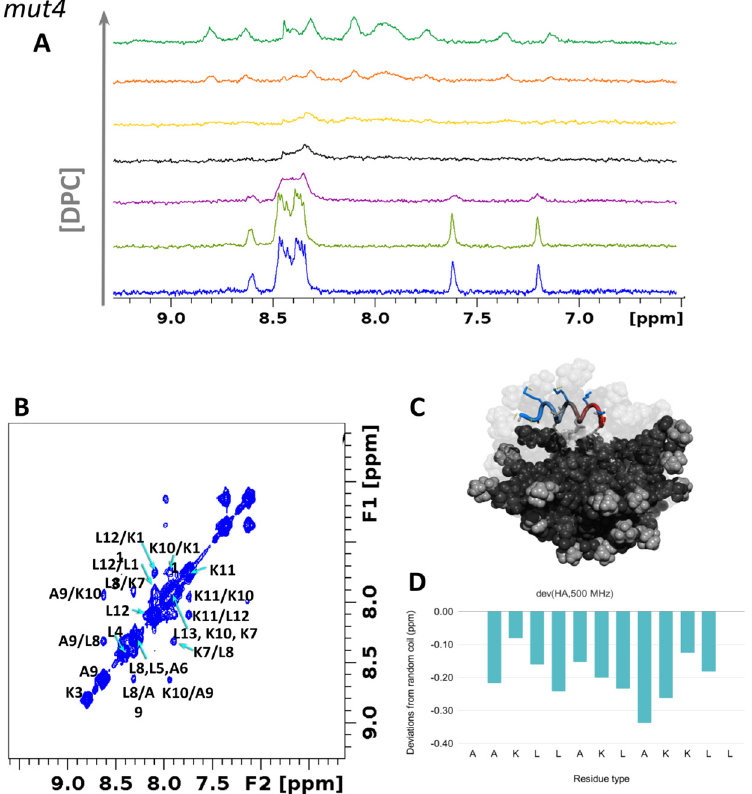
Figure 6. mut4 assumes alpha-helical conformation in a lipidic environment. ( A ) 1 H-NMR spectra of mut4 0.8 mM in the presence of DPC at concentrations of 2, 4, 8, 12, 24, and 50 mM. ( B ) 1 H, 1 H-NOESY spectrum of mut4 at 278 K in the presence of DPC micelles showing meaningful NOEs in the amide region. ( C ) MD snapshot of mut4 interacting with DPC micelles. The image was created with PyMol [76]. ( D ) Chemical shift deviations from random coil values of H α hydrogen atoms. Data on HB43 peptide were previously published [42].